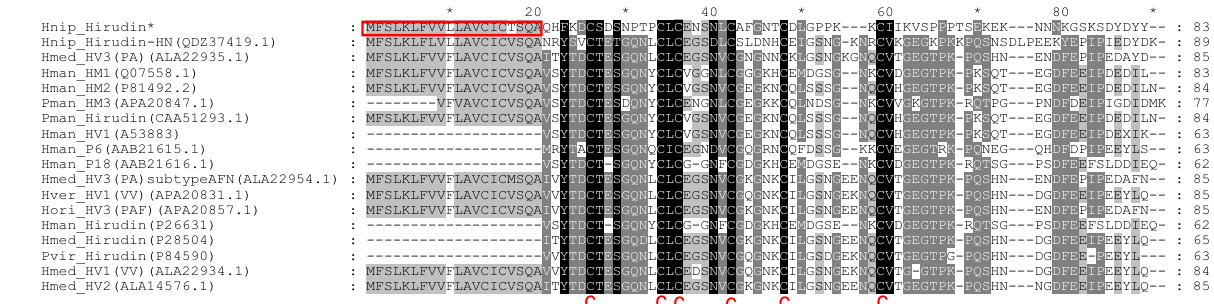
Figure 3. Alignment of hirudin protein amino acid sequences (*: candidate sequence from the present study; red box: predicted secretory signal peptides; C conserved cysteines residues, Hnip Hirudo nipponia , Hmed